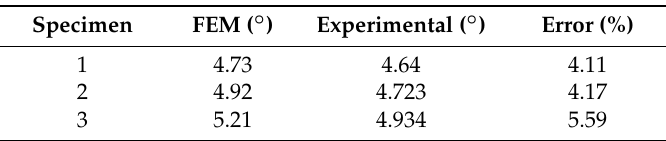
Table 6. Values of the angular distortion obtained with the proposed FE models and experimentally by use of a coordinate-measuring